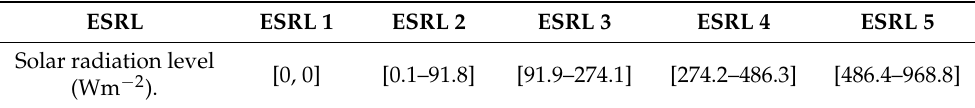
Table 8. Radiation levels in which the data collected in the 5 greenhouses were